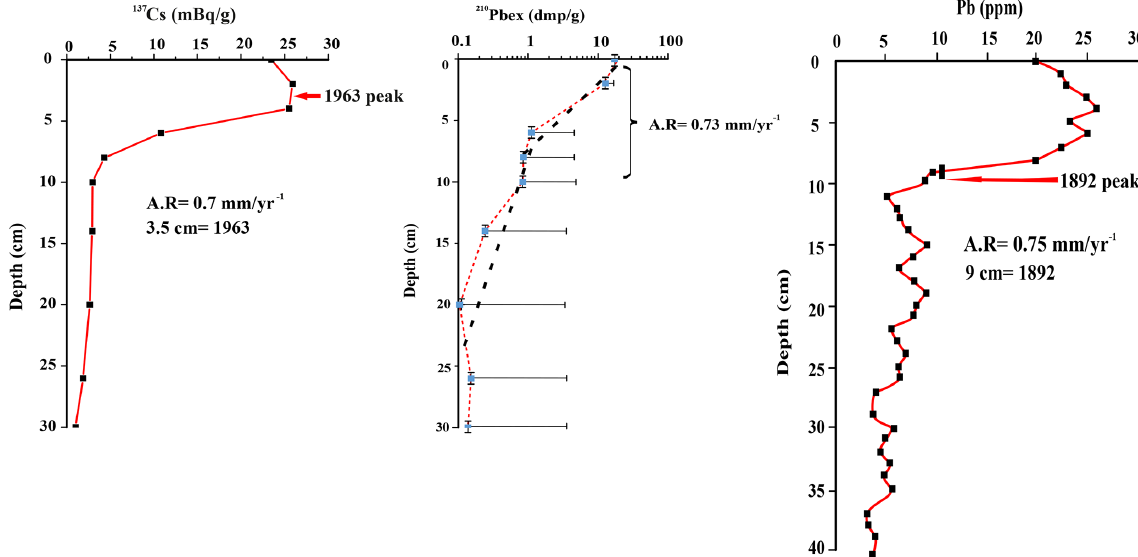
Figure 3. Distribution profile of 210 Pb ex , Pb, and 137 Cs vs. depth in GEM3. The 210 Pb data determine a sedimentation rate of 0.73mmyr − 1 . The activity depth profile Cs presents a peak at 3.5cm, indicating accumulation rates of 0.7mmyr − 1 for the 1963